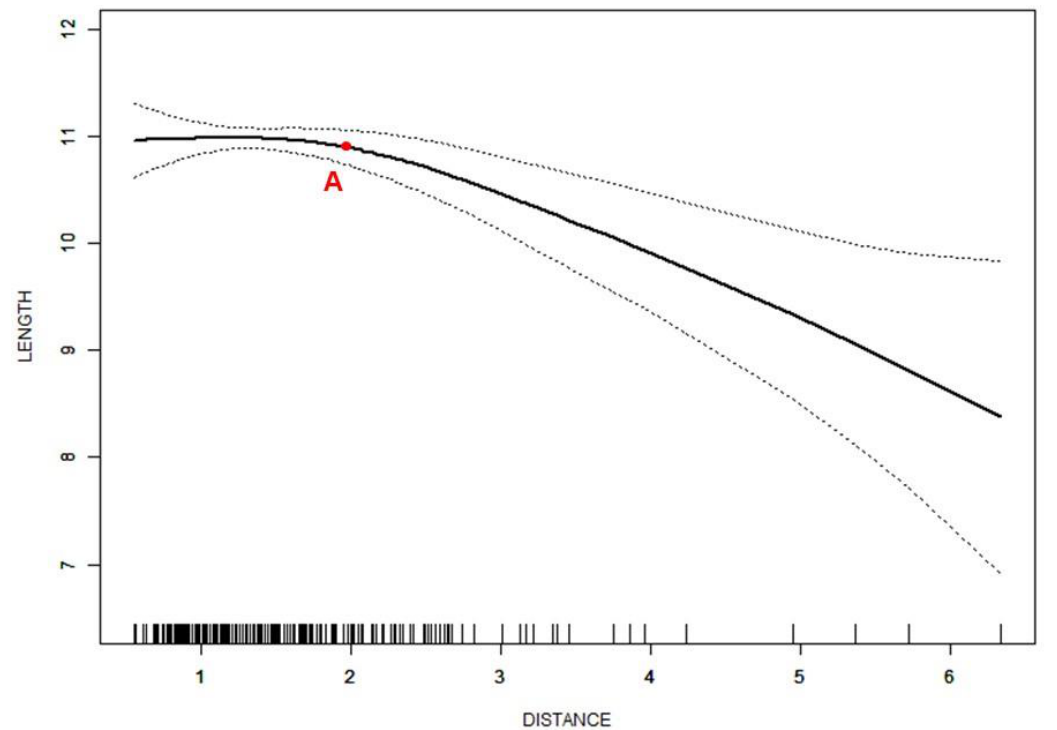
Figure 5. Nonlinear relationship between distance of disc displacement (mm) and disc length (mm) in cases with ADDWR. Adjusted for age and sex; ADDWR — anterior disc displacement with reduction; A — the turning point of 2.0 mm.